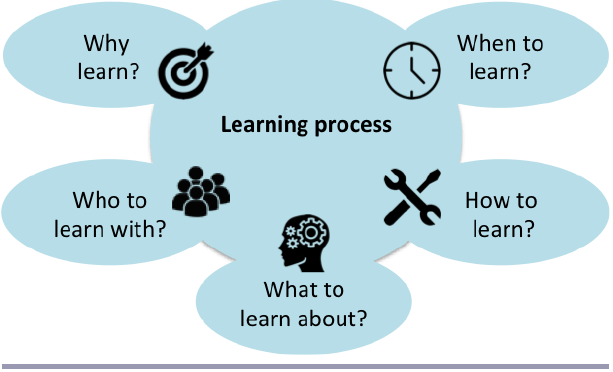
Fig. 1 . Analytical framework to assess the learning process in transdisciplinary research. Adapted from Enengel et al. (2012), Hoffmann et al. (2017), Roux et al.